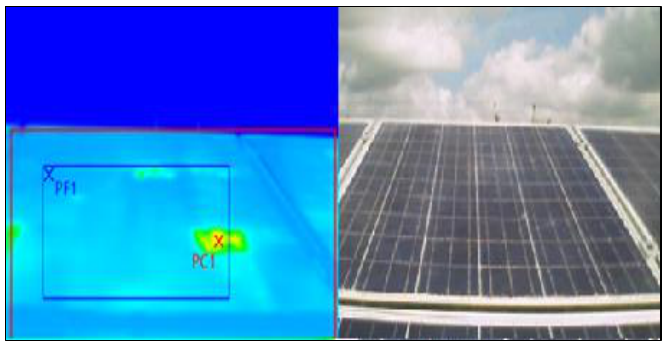
Figure 7: PV module covered partially by dirt. Table 6: Markers referring to the analysis of Figure 7.